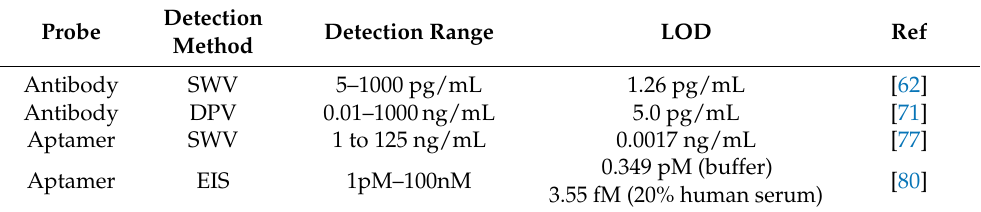
Table 2. Summary of electrochemical biosensing techniques discussed in this